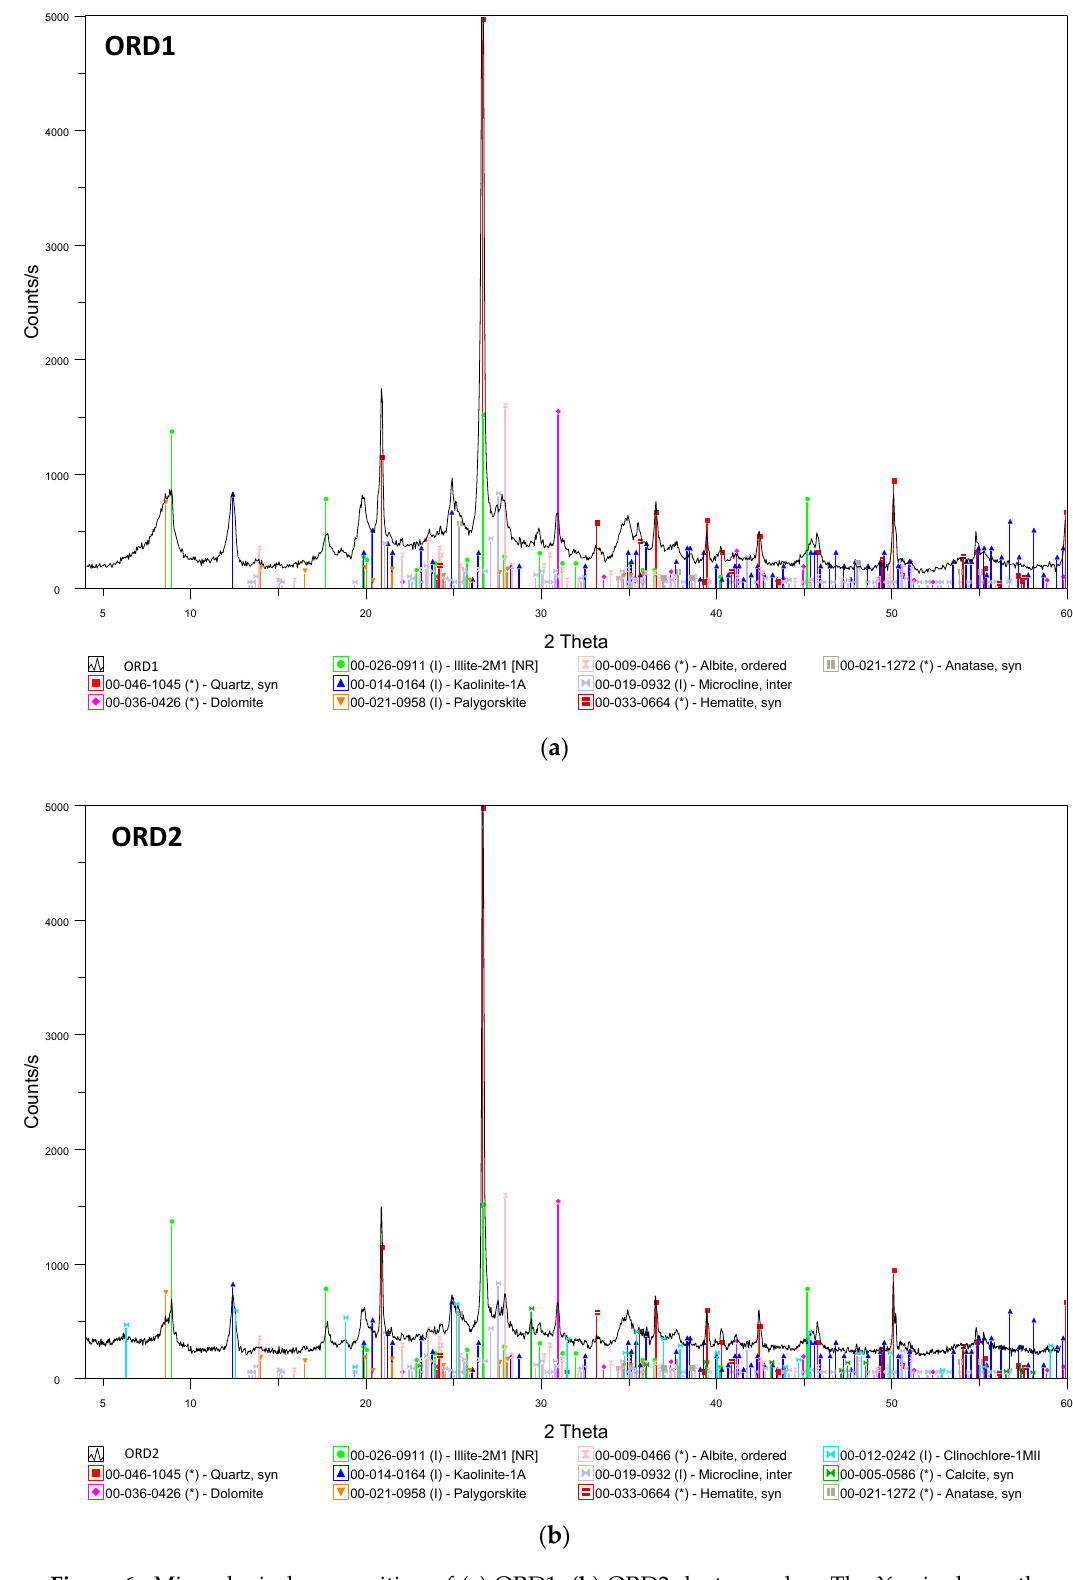
Figure 6. Mineralogical composition of ( a ) ORD1; ( b ) ORD2 dust samples. The Y -axis shows the intensity in counts / s and X -axis the 2 Theta, which is the angle between incident beam of X-ray and the crystallographic reflecting plane. Atmospheric deposition samples: ORD1, from 22 November to 5 December 2016; ORD2, from 31 January to 14 February